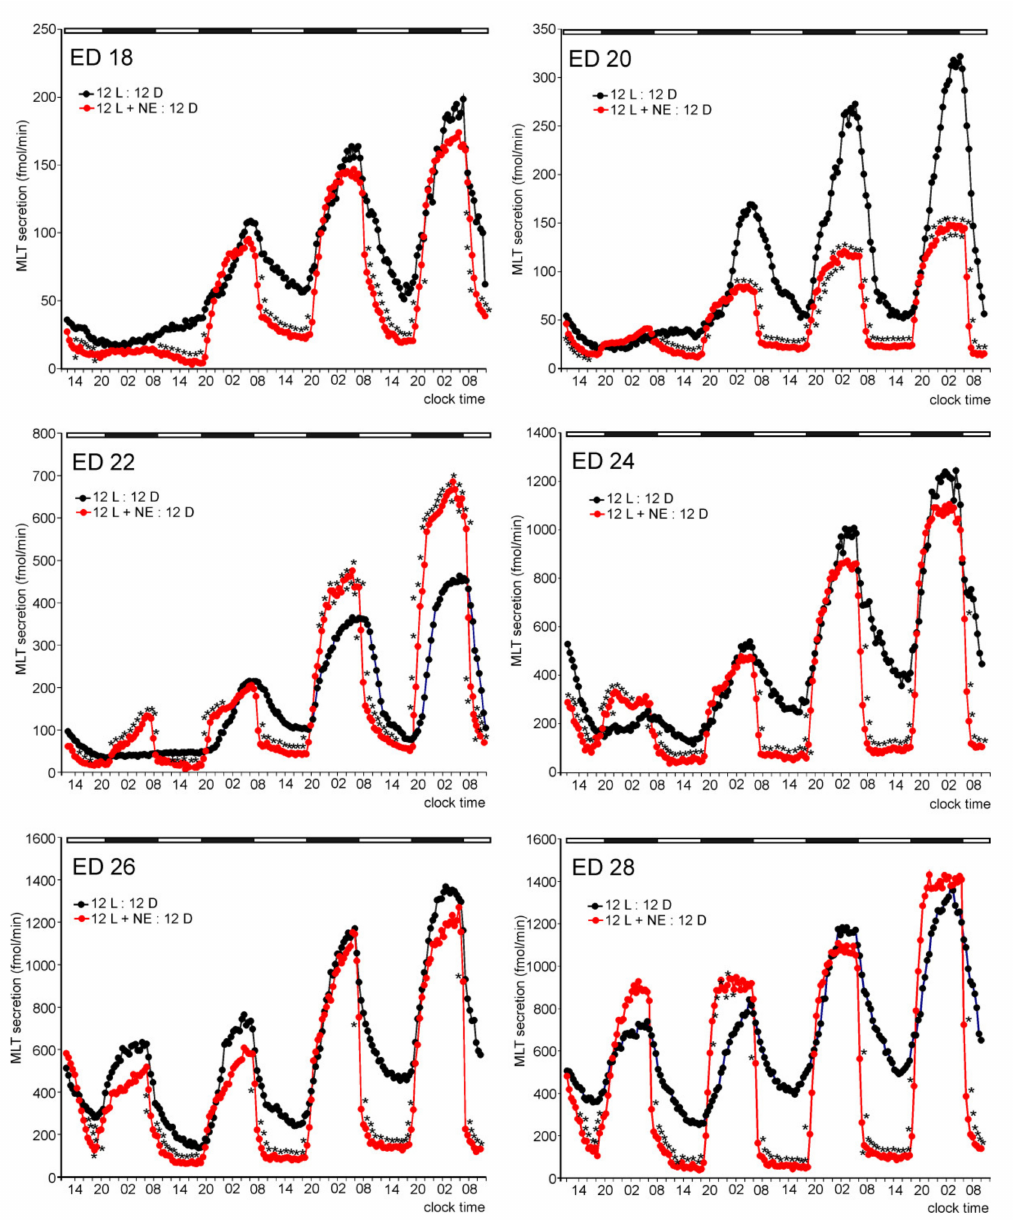
Figure 2. Comparison of MLT secretion (means, n = 4) from pineal organs of ED 18–ED 24 embryos incubated under a 12L:12D cycle with or without NE in the culture medium during photophase. Asterisks indicate significant differences between the pineal organs treated and untreated with